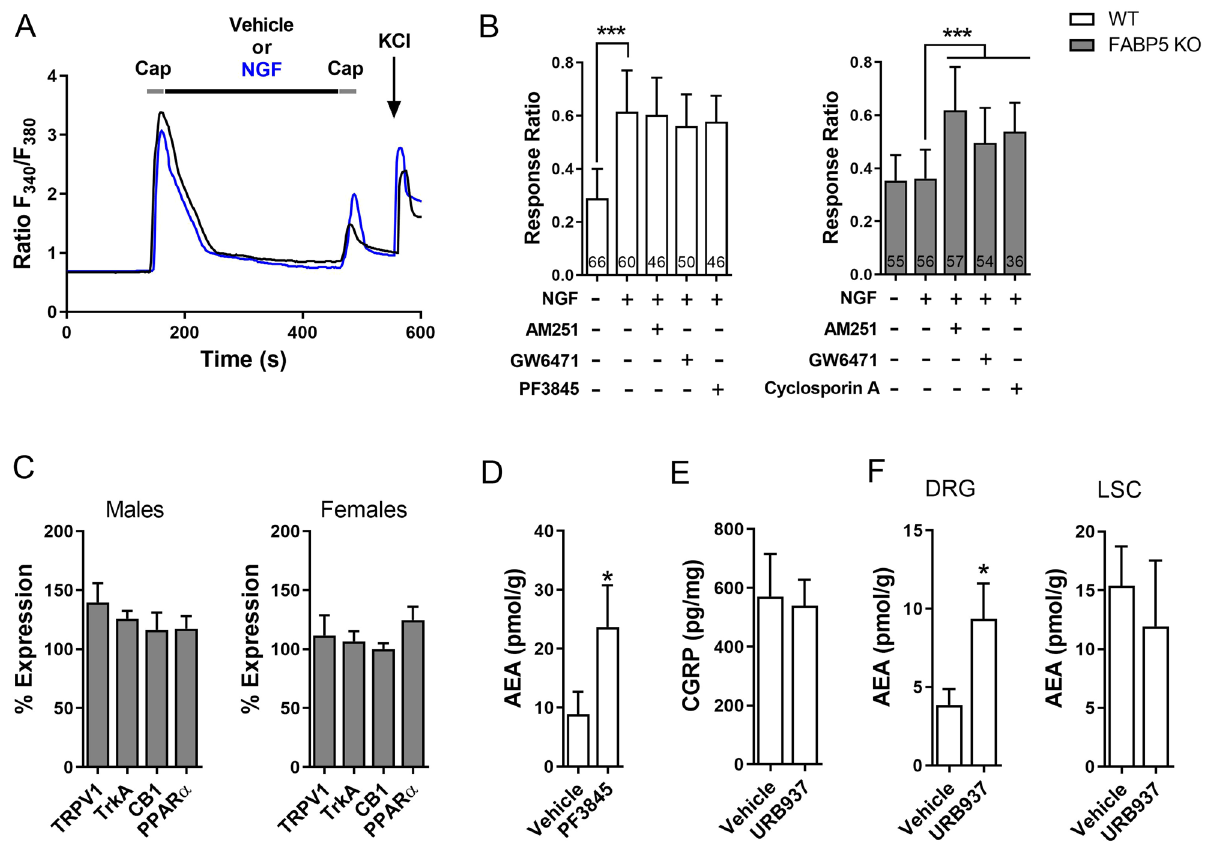
Figure 6. FABP5 deletion blunts NGF-mediated TRPV1 sensitization via CB1 and PPARα. ( A ) Design of calcium imaging experiment and representative calcium traces in WT and FABP5 KO DRGs incubated with NGF and capsaicin. DRG neurons received two 30 s pulses of 100 nM capsaicin (Cap, gray bars) interspersed with a 5 min incubation of vehicle (black trace) or 100 ng/ml NGF (blue trace). KCl was employed to confirm neuronal identity. ( B ) Capsaicin response ratio (2nd/1st peak) in WT (white bars) and FABP5 KO (gray bars) DRGs incubated with vehicle or NGF in the presence or absence of 3 µM AM251, 10 µM GW6471, or 200 nM cyclosporin A. The effect of FAAH inhibition upon capsaicin responses was evaluated by incubating WT DRGs with 1 µM PF3845 for 2 h prior to capsaicin application. *** p < 0.001 calculated using one-way ANOVA followed by Dunnett’s post-hoc test. ( C ) qPCR analysis of relative expression levels of TRPV1, TrkA, CB1, and PPARα in male and female FABP5 KO DRGs relative to WT controls (n = 3). ( D ) Levels of AEA in WT DRGs incubated for 2 h with vehicle or 1 µM PF3845. * p < 0.05 calculated using unpaired t test (n = 3). ( E ) Capsaicin-evoked CGRP release in WT mice administered vehicle or URB937 (1 mg/kg, i.p.). Mice received URB937 1 h prior to intraplantar carrageenan administration and spinal CGRP release elicited by 1 µM capsaicin was examined 4 h later (n = 5). ( F ) AEA levels in DRGs and lumbar spinal cords (LSC) of mice injected with vehicle or URB937 (1 mg/kg, i.p.). * p < 0.05 calculated using unpaired t test (n =